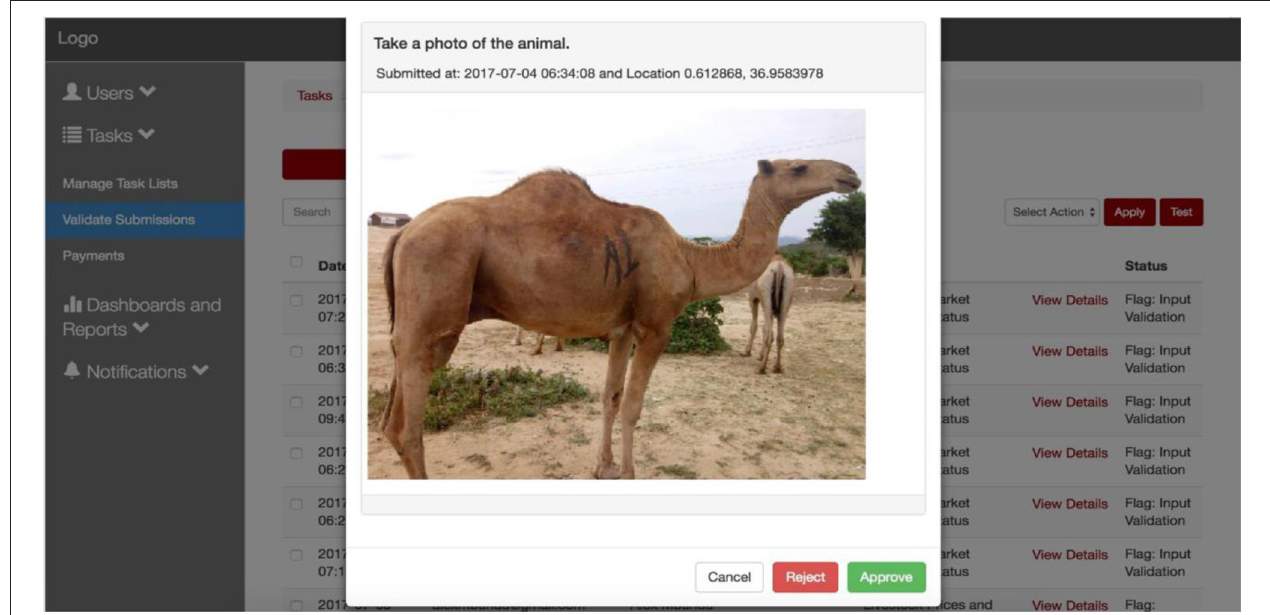
FIGURE 3 | Using KAZNET’s web application to validate a submitted task by checking its